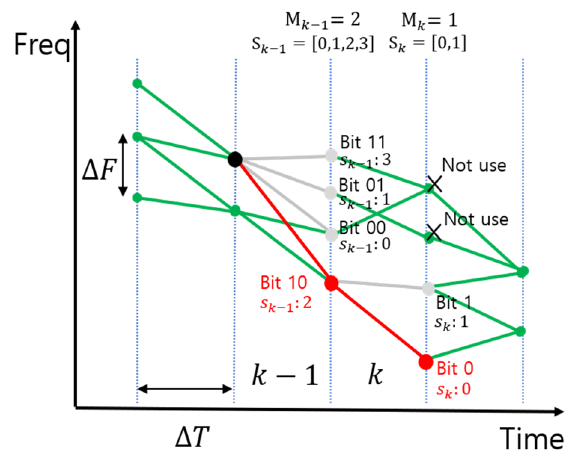
Figure 4. Example of a whistle-mimicking modulation signal.